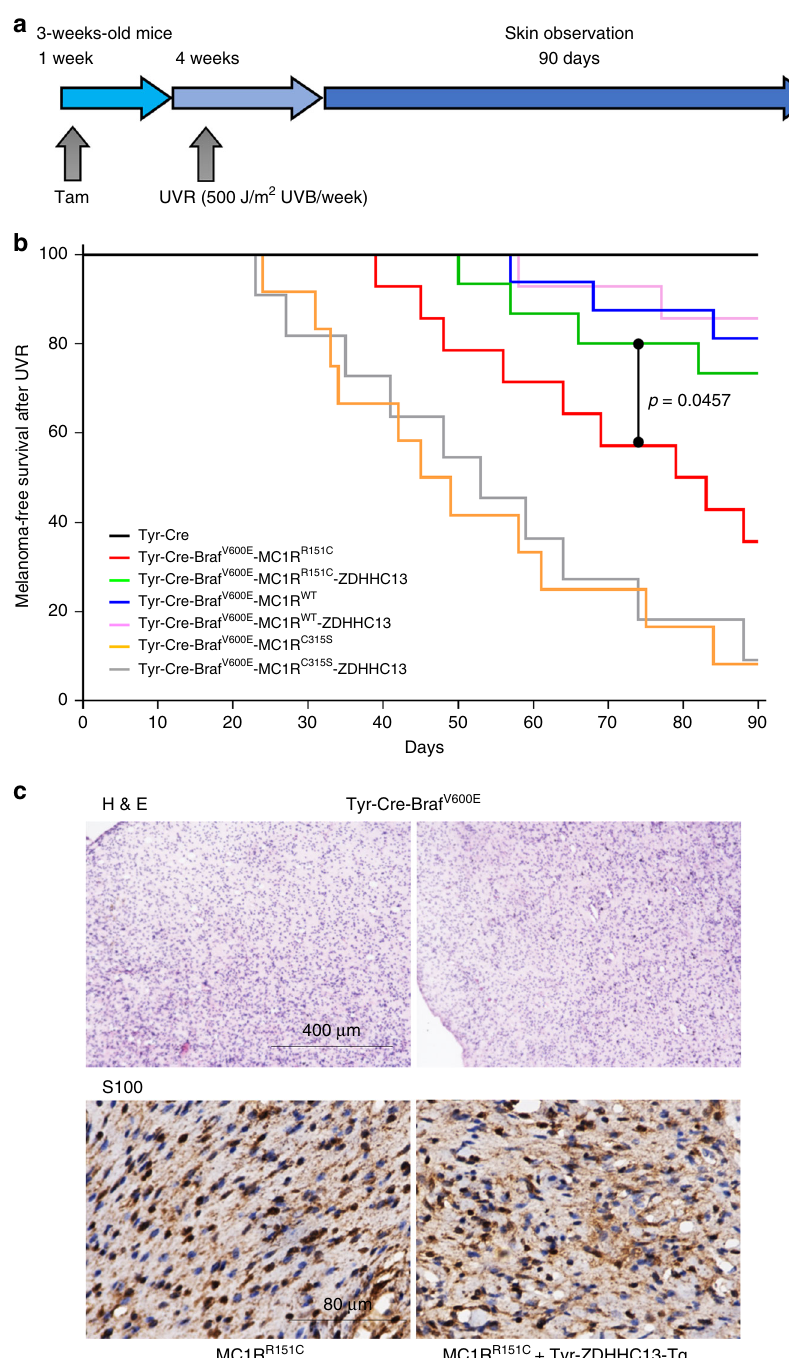
Fig. 3 Transgenic ZDHHC13 inhibits ultraviolet B (UVB)-induced melanomagenesis in redheads in vivo. a Schematic for UVB-induced melanoma development in mice. b Kaplan – Meier plot showing melanoma-free survival of the indicated mice. Ninety days after the fi nal UV radiation, melanoma was diagnosed in 92% (11/12), 64% (9/14), and 19% (3/16) of mice with MC1R C315S , MC1R R151C , and MC1R WT . Melanoma incidence was much lower in the Tg-ZDHHC13/MC1R R151C mice than in the MC1R R151C mice (27% (4/15) vs. 64% (9/14), log-rank test, p = 0.0457). c Hematoxylin and eosin staining of histological sections and immunohistochemistry staining of S100 of representative cutaneous melanomas. Genotypes were as therefore show that ZDHHC13-activated MC1R palmitoylation are all human melanoma TP53 mutation hotspots. To test the plays a critical role in melanoma prevention in vivo. mutations in our model, we sequenced PCR fragments covering these Trp53 mutation spots. Mutations in Trp53 (S124F, R245C, or R270C) were detected in 4/4 Tyr-Cre-Braf V600E -MC1R R151C mel- anomas but only 1/4 (R270C) in Tyr-Cre-Braf V600E -MC1R R151C - ZDHHC13 mice melanomas (Supplementary Fig. 2b). Our results